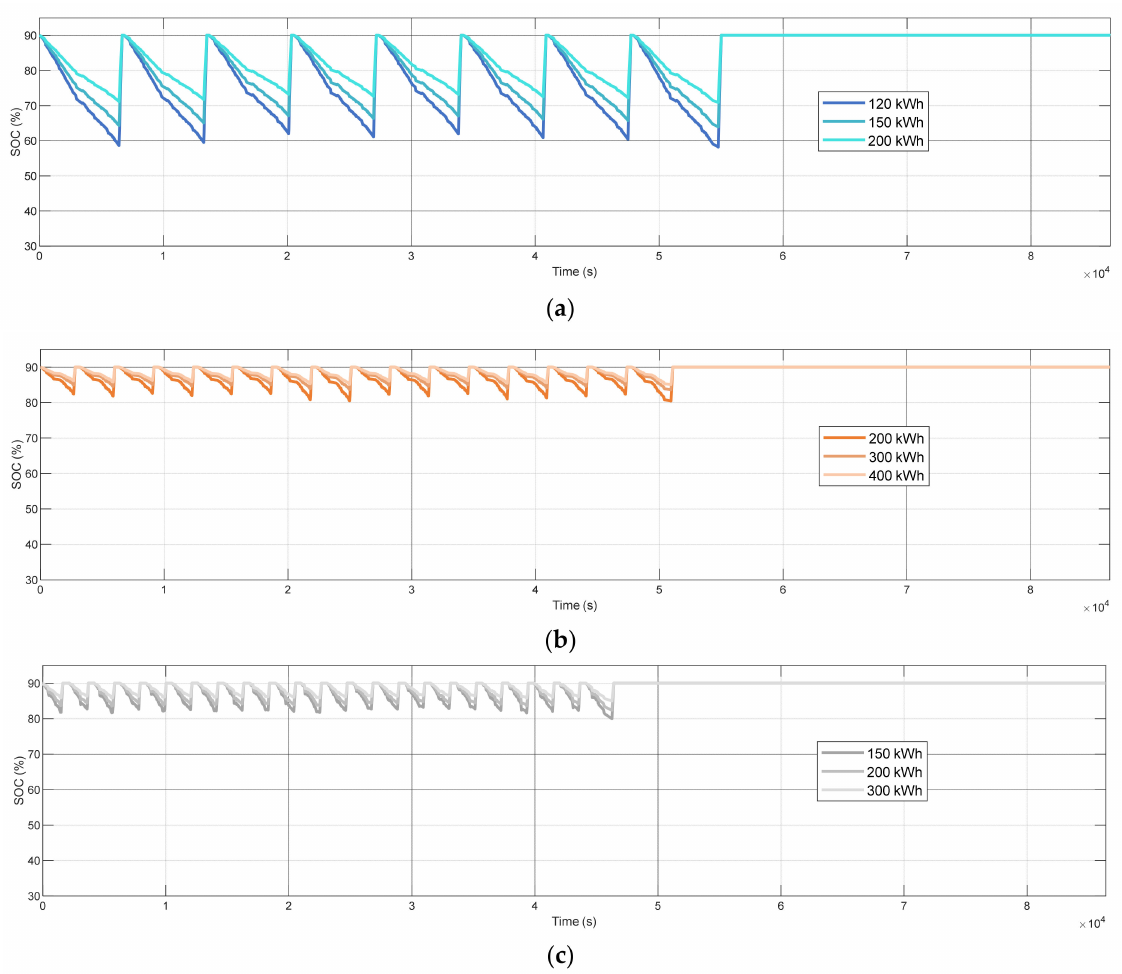
Figure 13. SOC profiles from simulation (1 January). ( a ) Barcelona Line, LTO chemistry. ( b ) Osnabrück Line, LFP chemistry. ( c ) Gothenburg Line, NMC